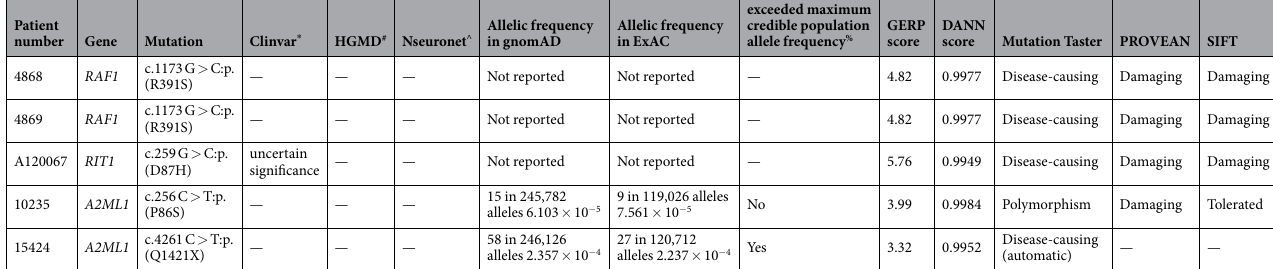
Table 2. A summary of five patients identified with VUSs from our cohort using the multigene panel sequencing approach. * Clinical significance was labelled according to the ClinVar database from NCBI (https://www.ncbi.nlm.nih.gov/clinvar/). # Variant class was determined according to the HGMD (Human Gene Mutation Database http://www.hgmd.cf.ac.uk/docs/new_help.html). ^ Variant classification was determined according to the NSEuroNet (European Network on Noonan Syndrome and Related Disorders; https://nseuronet.com/php/about.php). % The maximum credible population allelic frequency for Noonan syndrome (1.0 × 10 − 4 ) was calculated based on disease prevalence, maximum allelic contribution, maximum genetic contribution and penetrance 37 . Allelic frequency data was extracted from ExAC (Exome Aggregation Consortium;